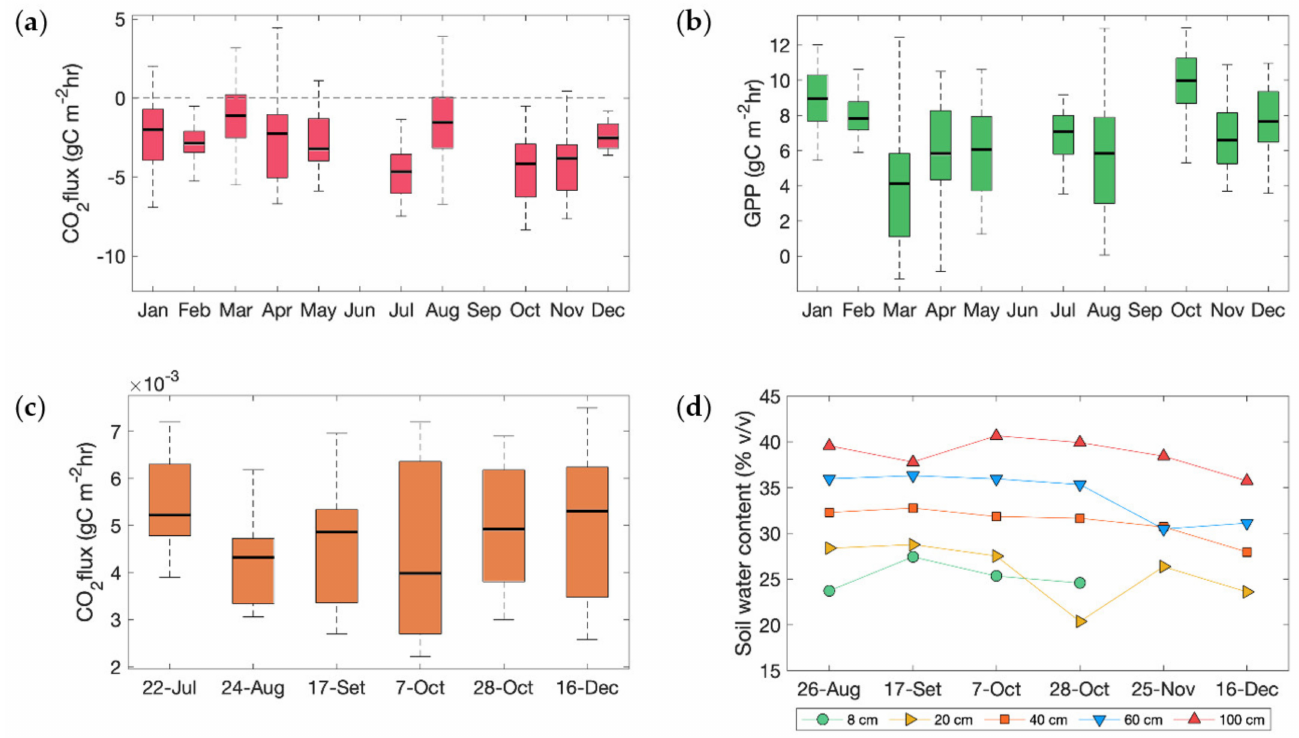
Figure 8. Preliminary results showing the annual cycle and variability of average ( a ) CO 2 flux and ( b ) gross primary productivity for the sun-exposed coffee plantation based on the EC measurements for 2020. Thick black lines in plot ( a ) are the means. ( c ) Average soil CO 2 fluxes ( µ mol m − 2 s − 1 ) from direct soil measurements with the LI-8100 and ( d ) soil water content (% v / v ) of the sun-grown coffee field. The measurement period for plots ( c , d ) was from July to December 2020 (n =